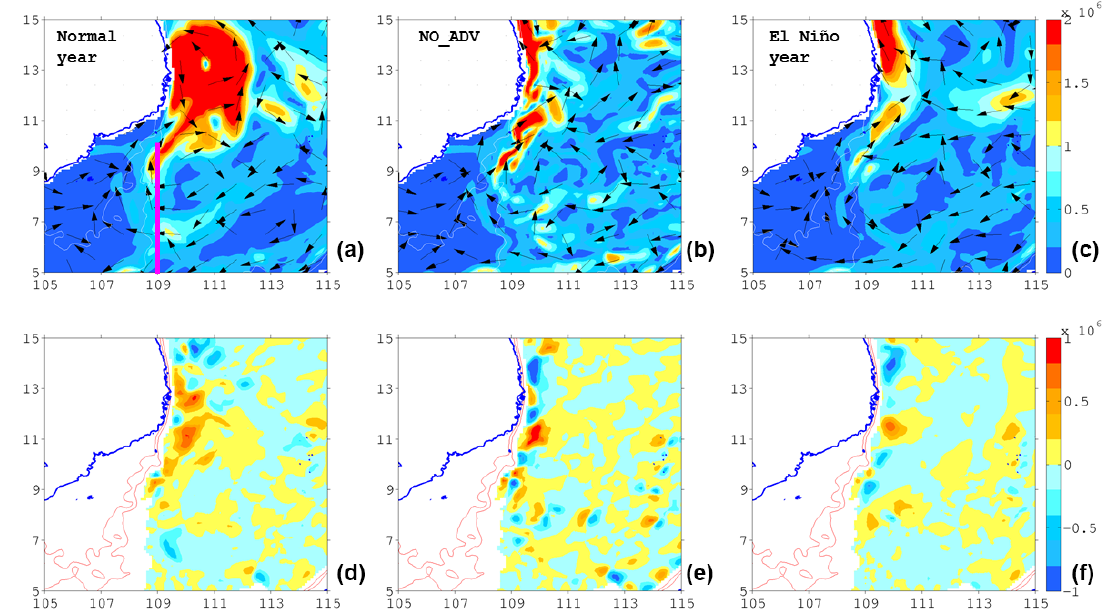
Figure 11. (a–c) Modeled 0–100m integrated nitrate fluxes (unit: mmols − 1 ) in horizontal plane. Color shading indicates the magnitude, while vectors denote the direction. (d–f) Vertical flux across 100m level for normal year ( a, d , years other than 2010), NO_ADV case (b, e) , and post-El Niño ( c, f , in 2010). Overlapped contours are the 50 and 75m isobaths. In panel (a) , the magenta line is the 109 ◦ E section (Table